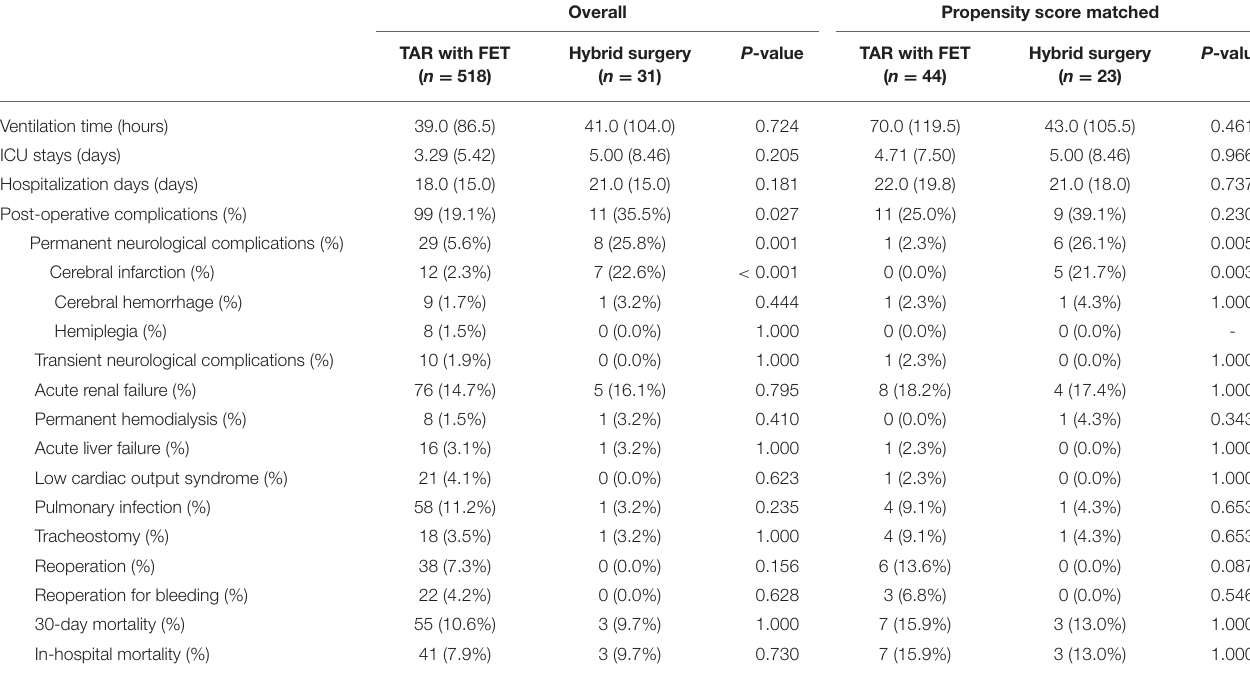
TABLE 3 | Short-term Prognosis.